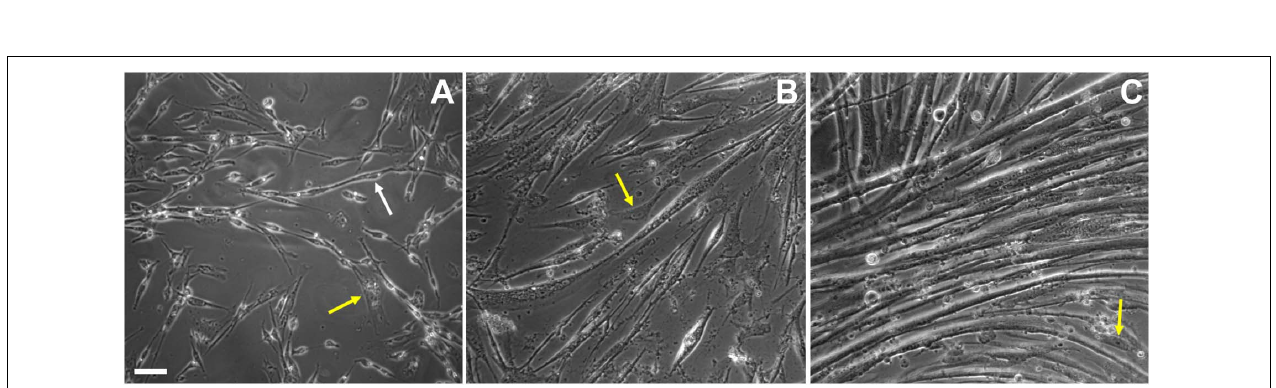
FIGURE 2 | Cell shape changes during in vitro chick myogenesis. Primary cultures of 11-day old chick myoblasts were grown for 24, 48, and 72 h and images were acquired under phase contrast microscopy. Bipolar myoblasts aligned in a pre-fusion chain-like structure (white arrow) are seen in a 24-h culture (A) , while thin myotubes are already present in a 48-h culture (B) and multinucleated myotubes are present in a 72-h culture (C) . Note the presence of fibroblasts in all the images ( A–C , yellow arrows). Scale bar = 10 µ m.